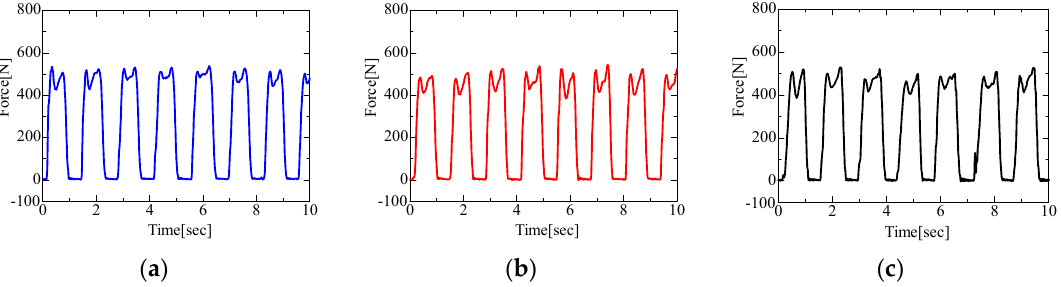
Figure 7. Results for vertical force in gait conditions: ( a ) low target load; ( b ) medium target load; ( c ) high target